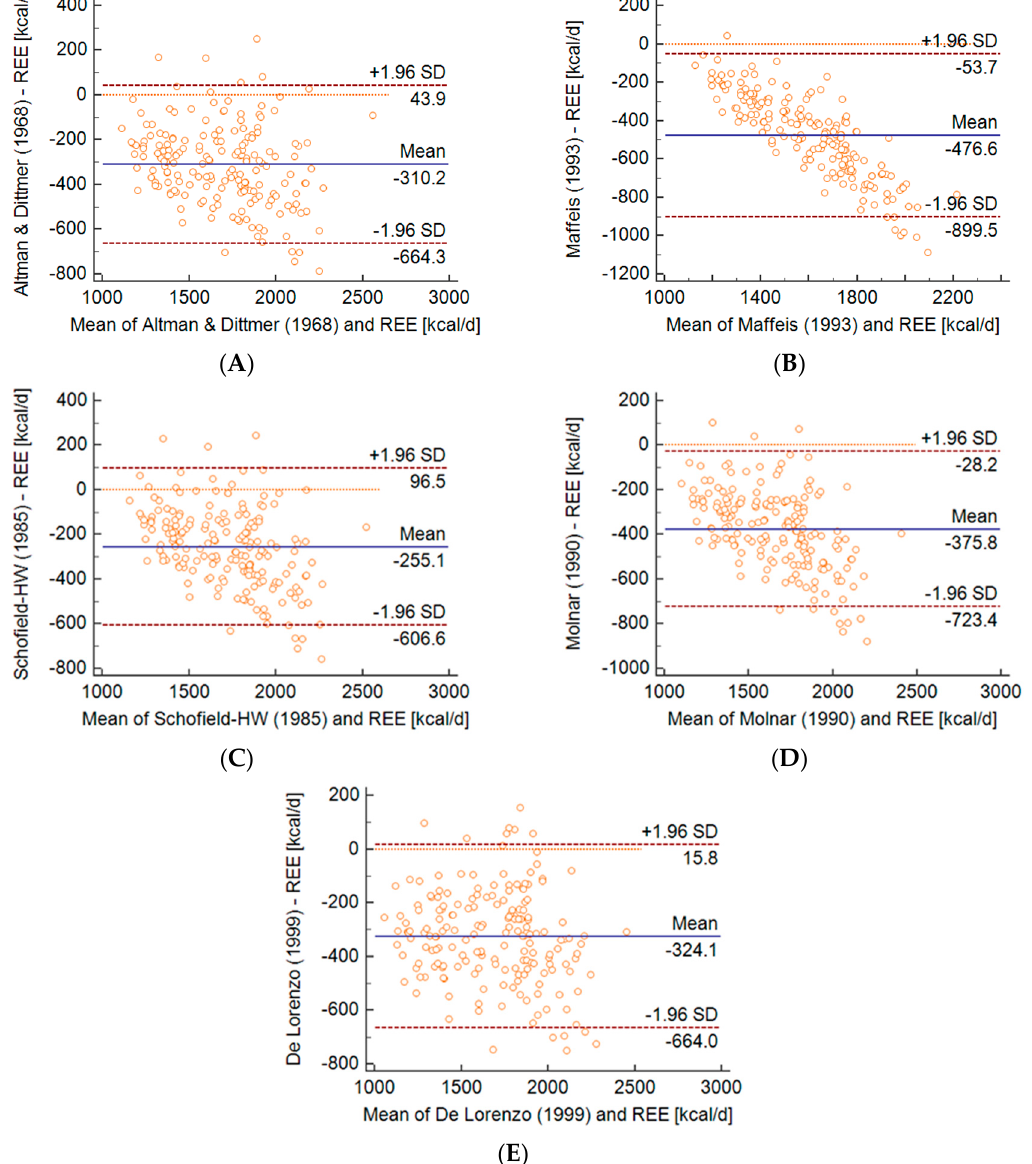
Figure 2. Bland-Altman plots the presenting the agreement between measured and predicted REE by the equations of ( A ) Altman and Dittmer, ( B ) Maffeis, ( C ) Schofield Henry William (Schofield-HW), ( D ) Molnar, ( E ) De Lorenzo. All of the formulas above were used in the selection of children who regularly exercise. The mean value of the differences between measured and predicted REE (bias) is indicated by the solid line. The dashed lines delimit the 95% confidence interval. All regression lines were statistically significant at p < 0.0001, indicating a systematic bias.